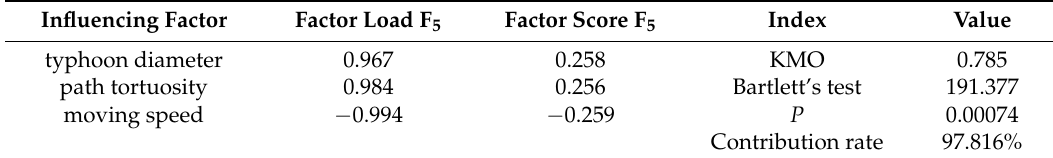
Table 6. Factor analysis of